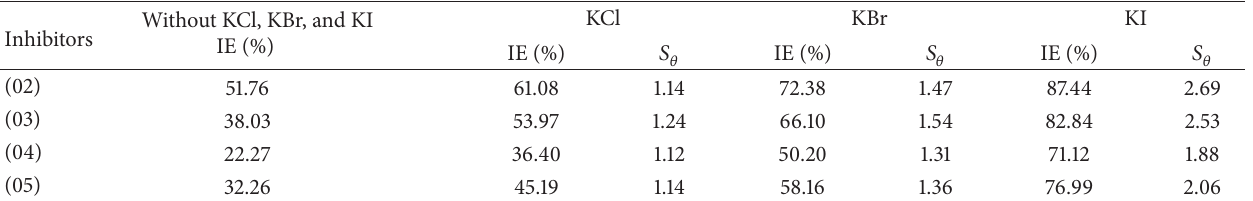
Table 4: Inhibition efficiency and synergism parameter of variously substituted 2,6-diphenylpiperidin-4-ones (0.4 × 10 − 3 M) and KCl, KBr, SO and KI (1 × 10 − 3 M) systems in 1N H 2 4